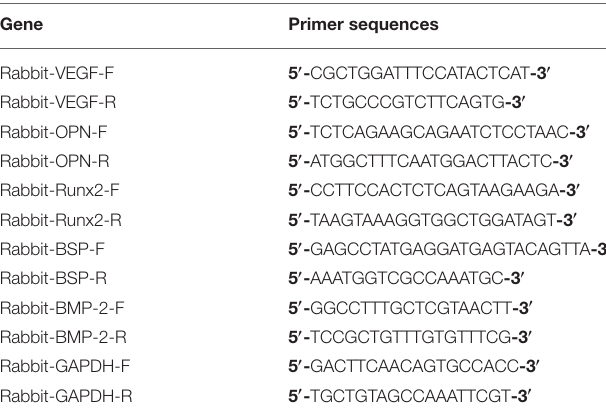
TABLE 1 | Primer sequences used in quantitative reverse-transcriptase polymerase chain